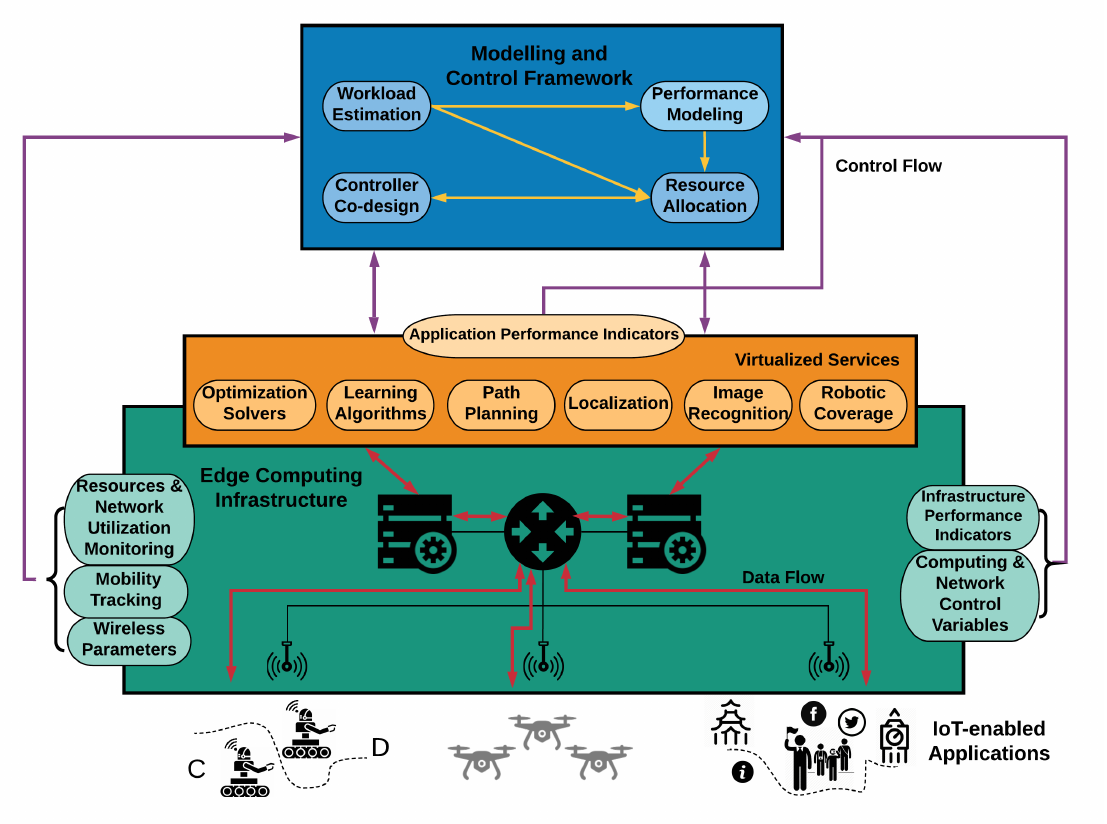
Figure 1. Conceptual